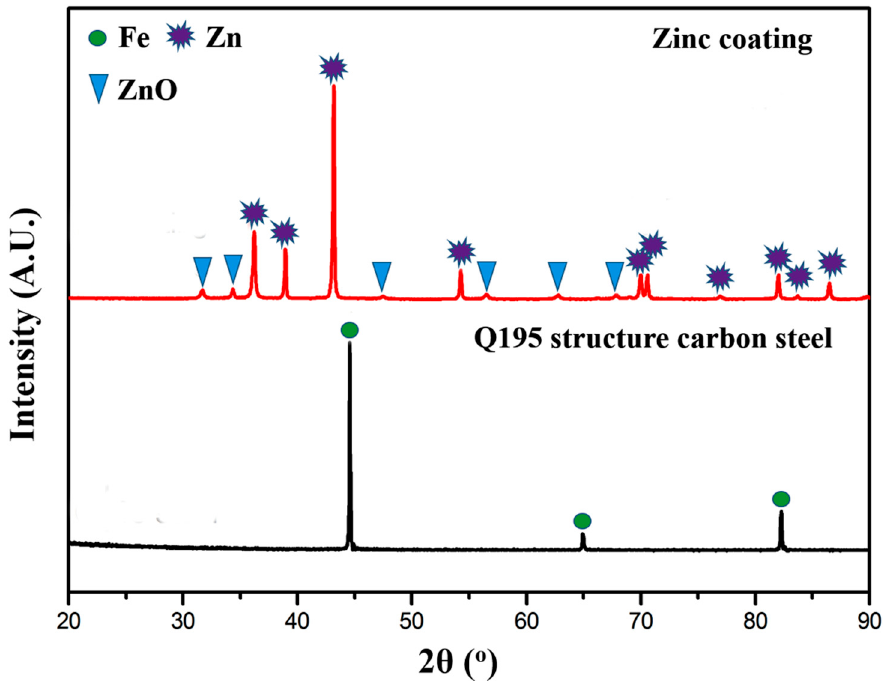
Figure 8. XRD patterns of Q195 structure carbon steel: With 40 s EPP treatment ( black line ); After Zinc coating ( red line ).